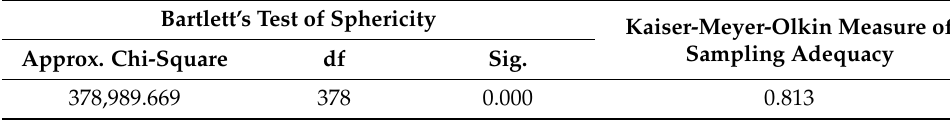
Table 2. KMO and Bartlett’s